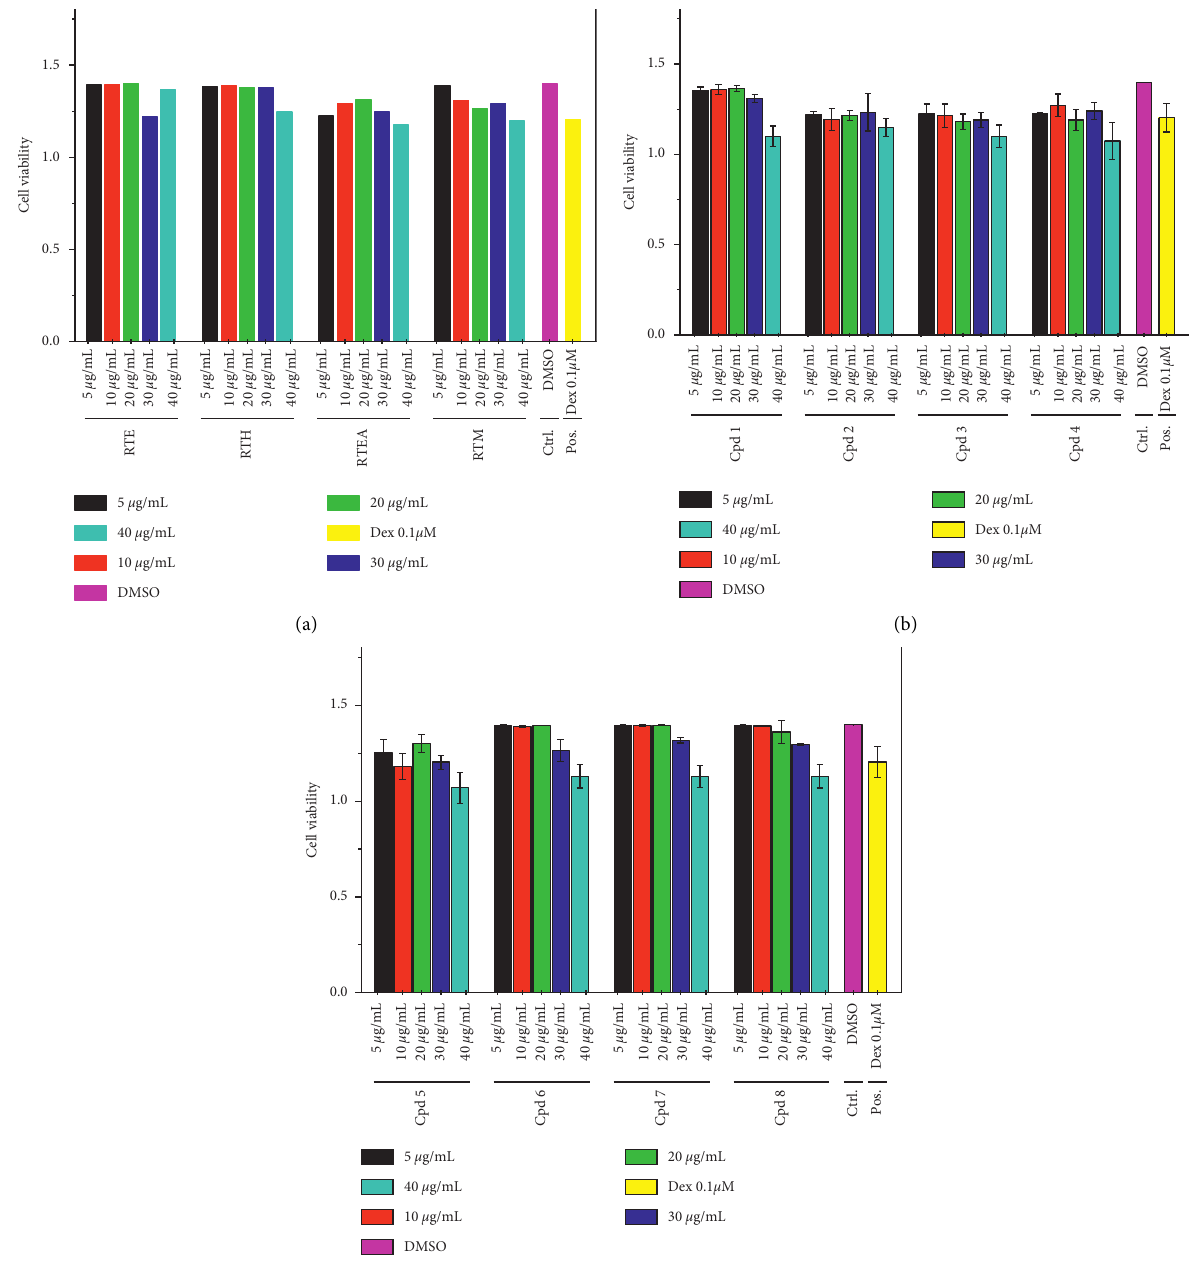
Figure 1: Effect of (a) extract, (b) compounds 1–4, and (c) compounds 5–8 on RAW 264.7 macrophage cell viability. Cells were incubated for 24h with the indicated concentrations (5, 10, 20, 30, and 40 μ g/mL). Data are expressed as mean ± S.D. of three independent ex- periments. RTH: n-hexane fraction; RTEA: ethyl acetate fraction. RTM: methanol fraction; RTE: crude ethanol